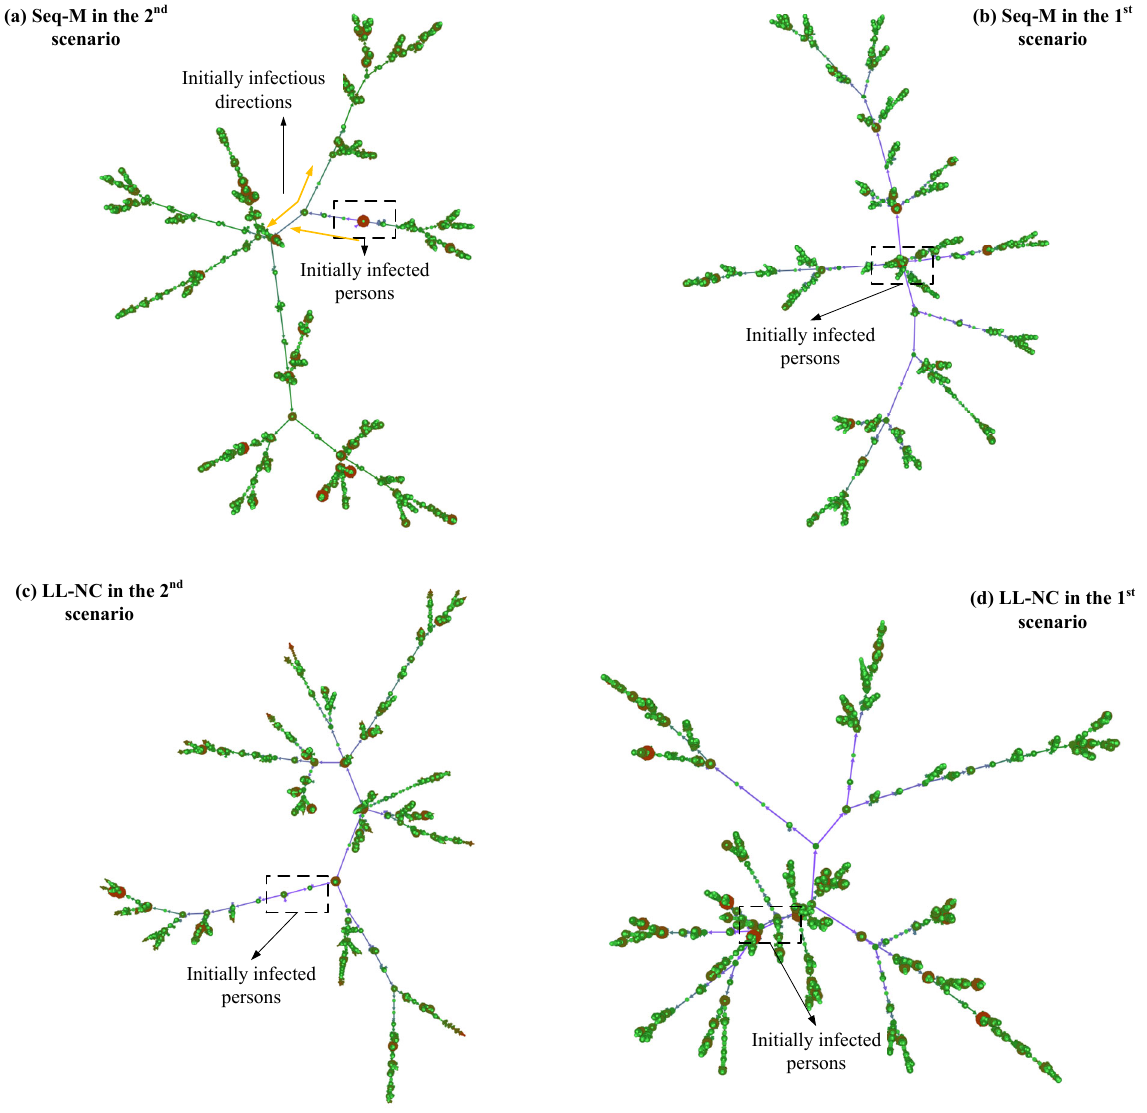
Figure 13. Diffused networks using Seq-M and LL-NC in the two scenarios. These are directed networks. The larger the degrees of nodes, the larger the diameter of circles. The more nodes are clustered, the larger the density of the connections between nodes.